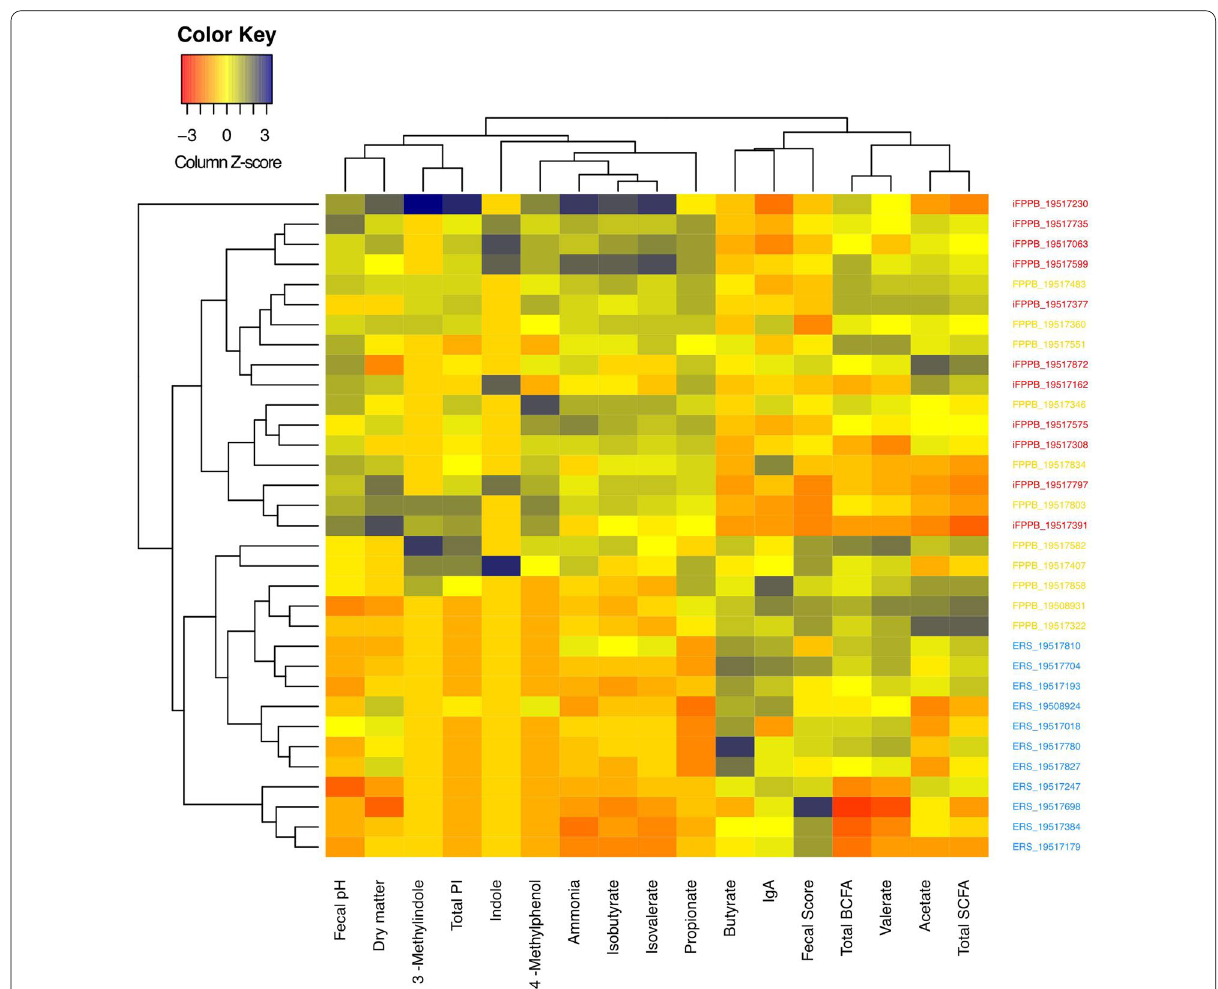
Fig. 1 Heatmap of fecal characteristics and metabolite concentrations of cats fed the experimental diets. The data show differences among diet groups, with those fed ERS (blue text) clustering separately from those fed FPPB (yellow text) and iFPPB (red text)